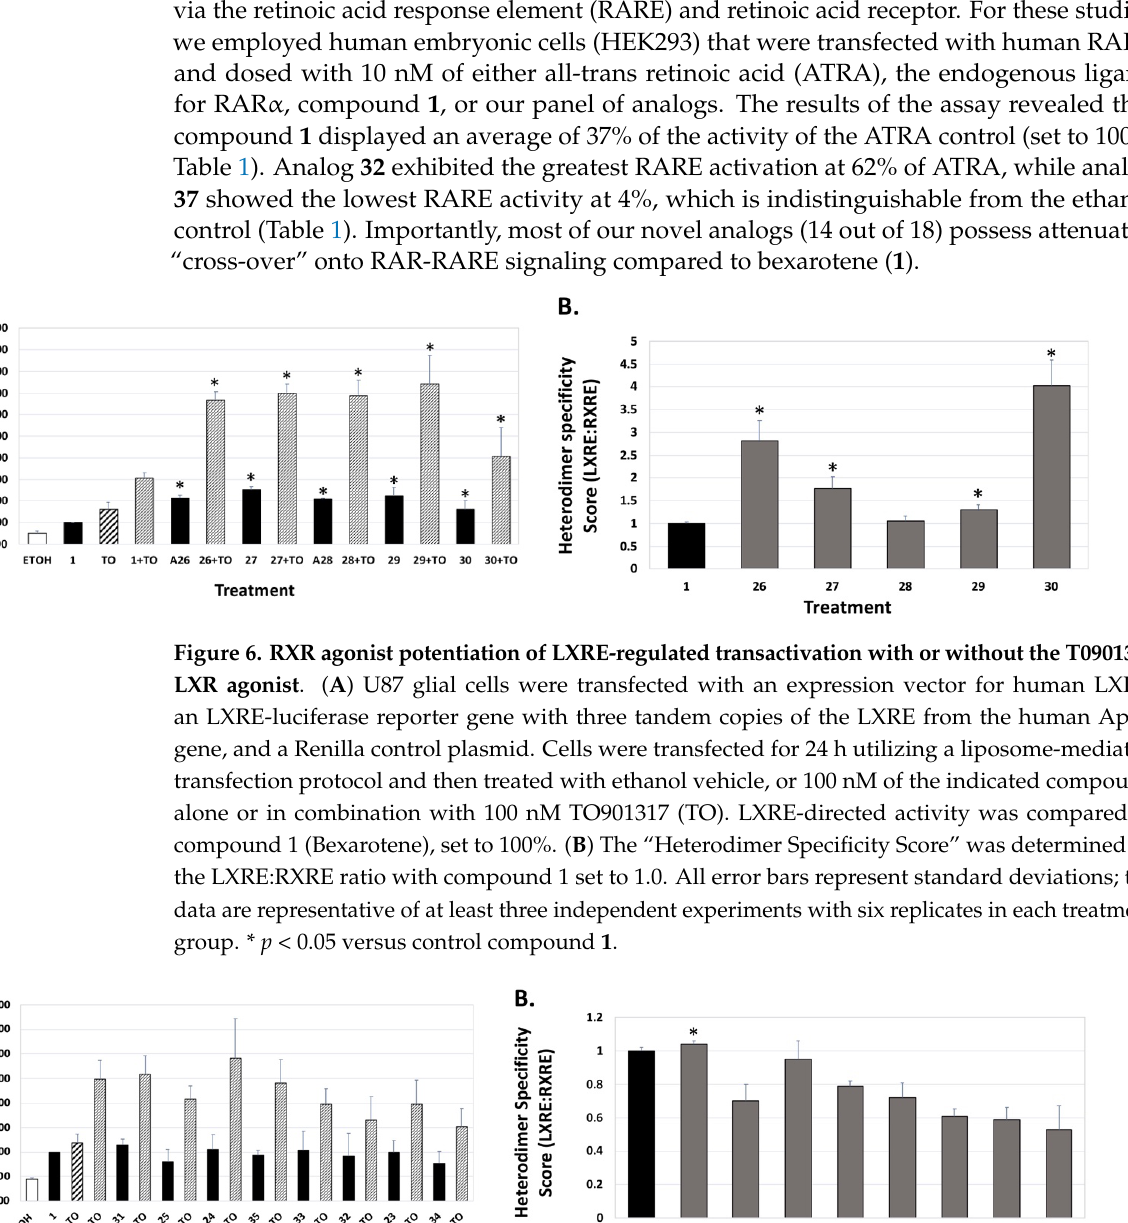
Figure 8 . Evaluation of RXR agonists to potentiate LXRE-mediated transactivation in the absence and presence of LXR ligand T0901317 . ( A ) U87 glial cells were transfected with an expression vector for human LXRα, an LXRE -luciferase reporter gene with three tandem copies of the LXRE from the human ApoE gene, and a Renilla control plasmid. Cells were transfected for 24 h utilizing a lipo- some-mediated transfection protocol and then treated with ethanol vehicle, or 100 nM of the indi- cated compound alone or in combination with 100 nM TO901317 (TO). LXRE-directed activity was compared to compound 1 (Bexarotene), set to 100%. ( B ) The “Heterodimer Specificity Score” was determined by the LXRE:RXRE ratio with compound 1 set to 1.0. All error bars represent standard deviations; the data are representative of at least three independent experiments with six replicates in each treatment group. * p < 0.05 versus control compound 1. Finally, even though compound 1 is selective for binding to RXR, it does include some “residual” RAR activity. We assessed the potential of our analogs to induce tran- scription via the retinoic acid response element (RARE) and retinoic acid receptor. For these studies, we employed human embryonic cells (HEK293) that were transfected with human RARα and dosed with 10 nM of either all -trans retinoic acid (ATRA), the endoge- nous ligand for RARα, compound 1 , or our panel of analogs. The results of the assay re- vealed that compound 1 displayed an average of 37% of the activity of the ATRA control (set to 100%, Table 1). Analog 32 exhibited the greatest RARE activation at 62% of ATRA, while analog 37 showed the lowest RARE activity at 4%, which is indistinguishable from